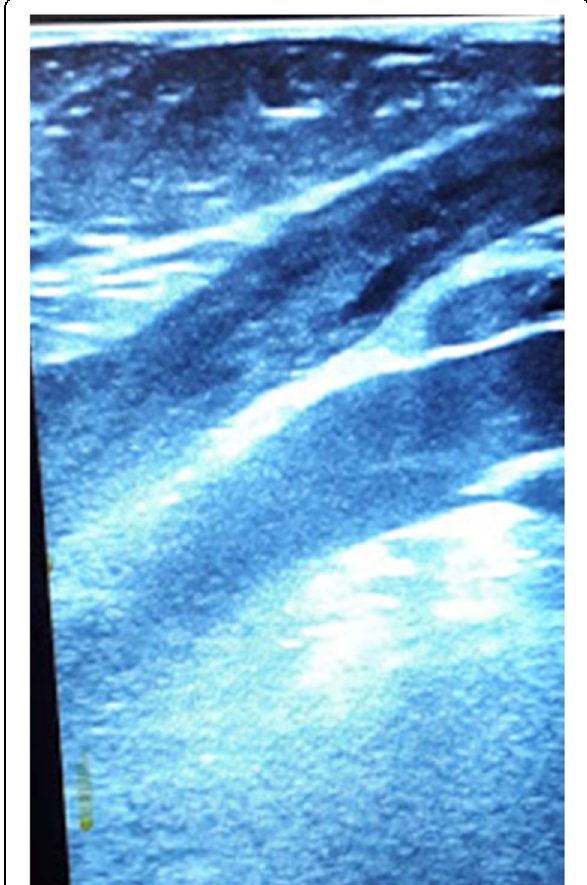
Fig. 9 Refluxing short saphenous vein thigh extension after 3% Pol. USGFS injection showing partial